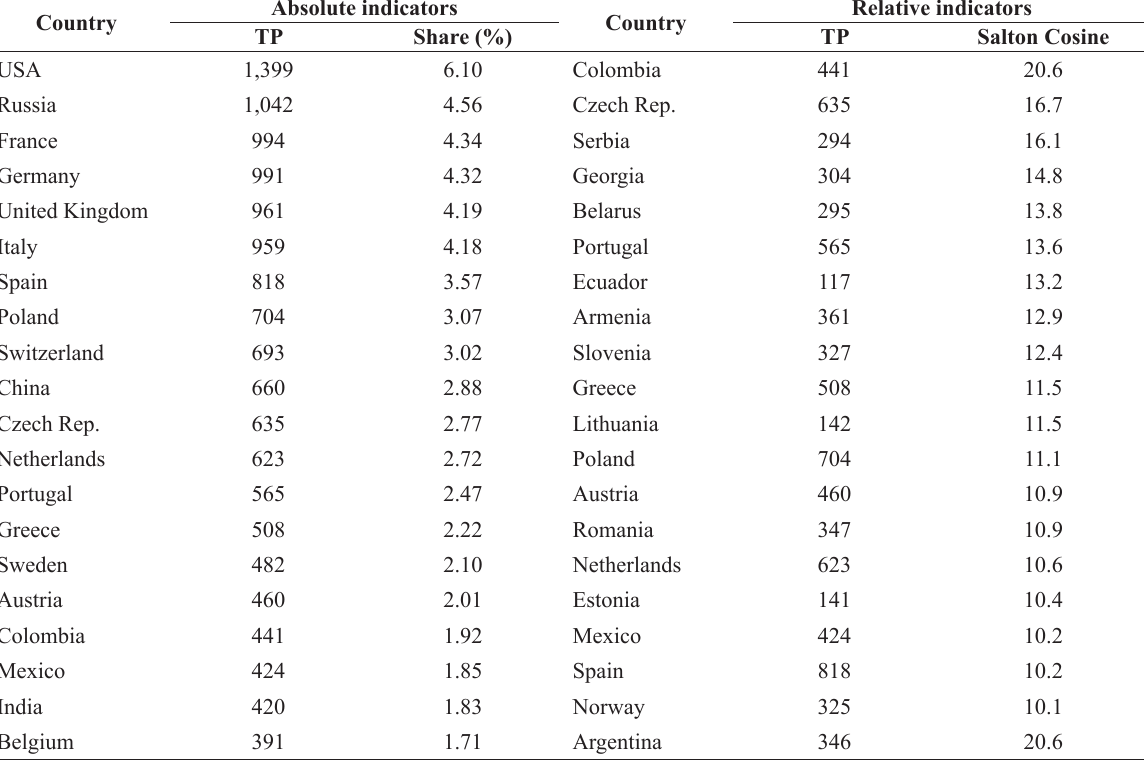
Main countries collaborating with Brazil in HEP, 1983-2013.